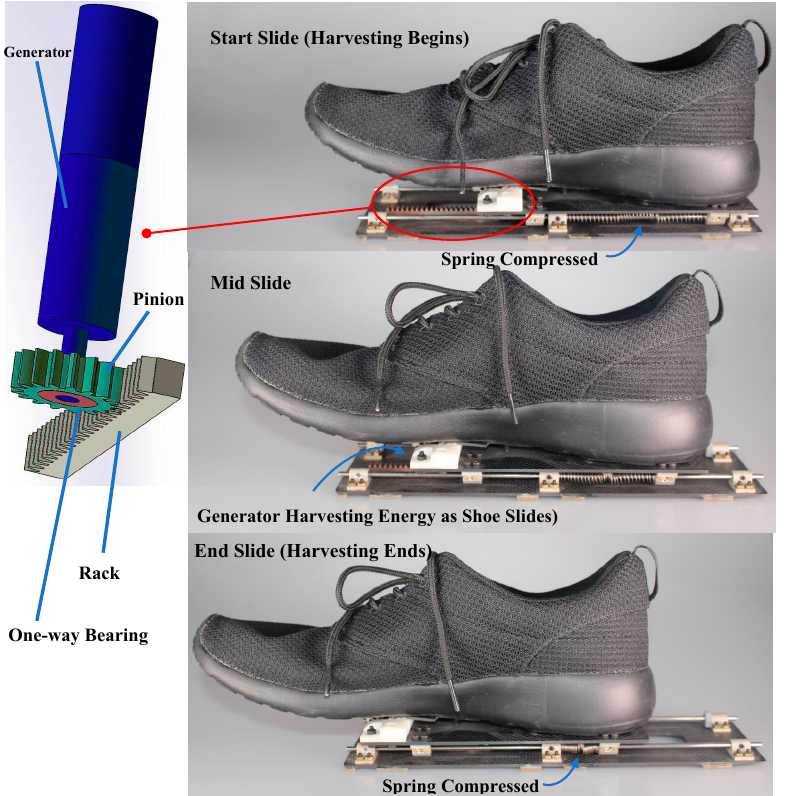
Figure 1. Custom sliding shoe created by mounting a sliding mechanism to the sole of a standard walking shoe. A rack-and-pinion converts linear sliding motion to rotational motion of the generator. Energy is harvested as the shoe slides during the stance phase of gait by the generator on the sliding mechanism. The compressed spring returns the sliding mechanism to the original position during the swing phase when the shoe is not in contact with the ground.